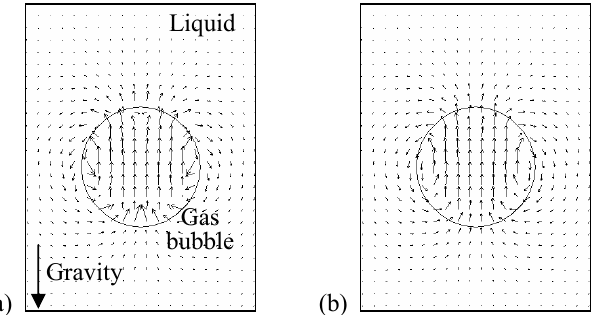
Fig. 3 Velocity distribution near gas bubble interface: (a) unphysical distribution, (b) physically appropriate distribution by improved formulation